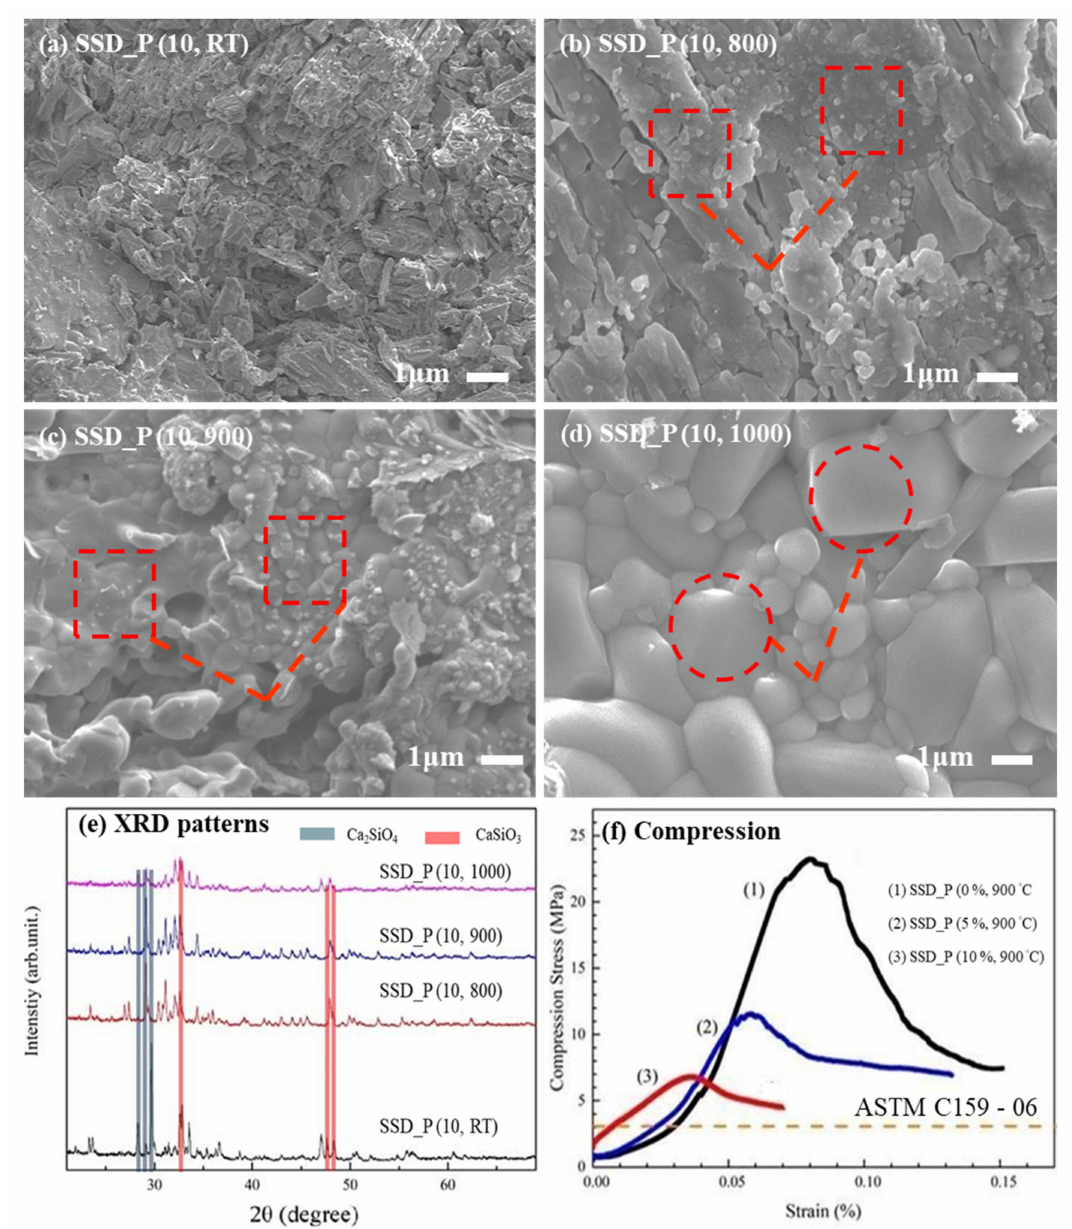
Figure 2. SEM morphologies from the surfaces of SSD_P (x, y), where x is 10% and y is annealed at ( a ) room temperature, ( b ) 800, ( c ) 900, and ( d ) 1000 ◦ C, respectively. As the annealing temperature increases, recrystallization (e.g., marked in squares) and then grain growth (e.g., marked in circles) of SSD_P (x, y) can be observed. ( e ) XRD patterns and ( f ) the measured compression stress of SSD_P (10%, 900 ◦ C) are measured by taking SSD_P (0%, 900 ◦ C) and SSD_P (5%, 900 ◦ C) as the references. A required strength based on ASTM C159-06 [38] is also